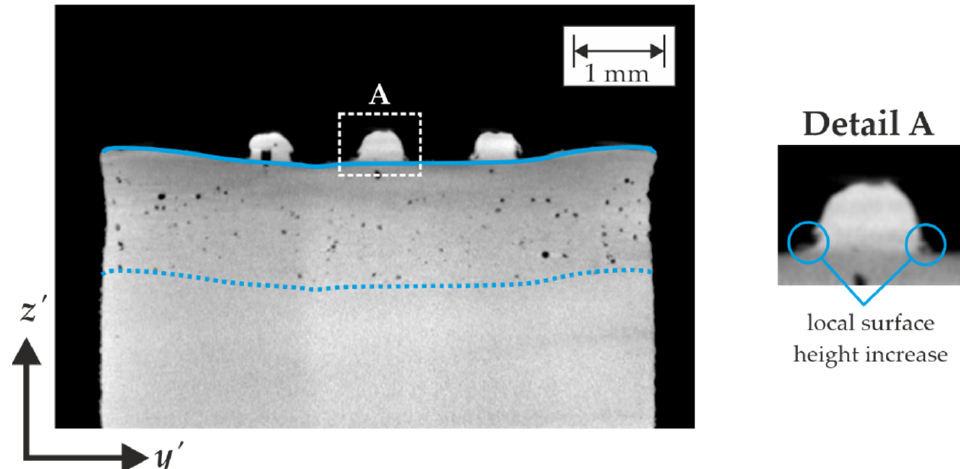
Figure 4. Cross-sectional slice of XCT reference volume at a depth of x’ = 3 mm. Gray value variations in the bulk material are image artifacts originated by the cone-beam reconstruction of strong absorbing material. Height elevations on the surface rim and lateral shrinkage in the section of increased VED are visible. The approximated top surface shape (continuous blue line) is repeated below (dashed blue line) for a better comparison with the pore distribution. In Detail A, the areas of local surface height increase close to the landmarks are marked by blue circles.